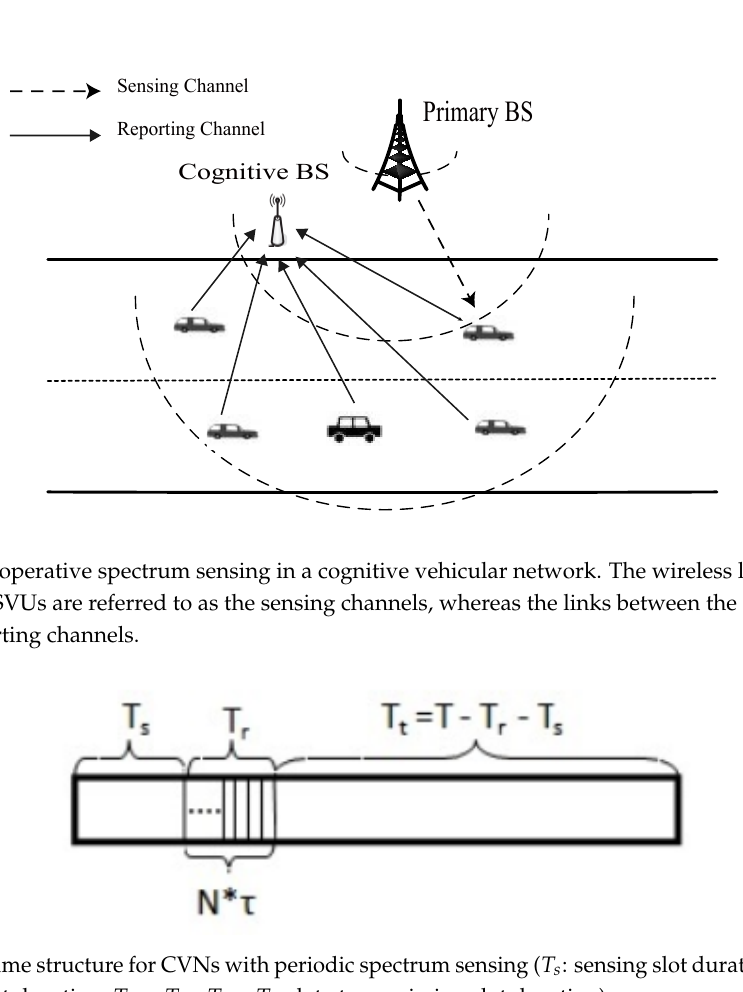
Figure 2. Frame structure for CVNs with periodic spectrum sensing ( T s : sensing slot duration; T r = N τ : reporting slot duration; T t = T − T s − T r : data transmission slot